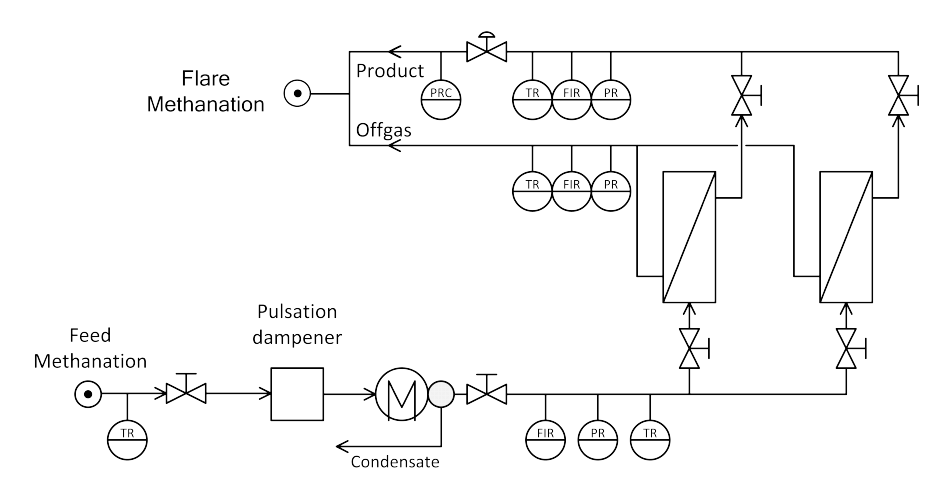
Figure 10. Simplified flow sheet of the lab scaled membrane plant.